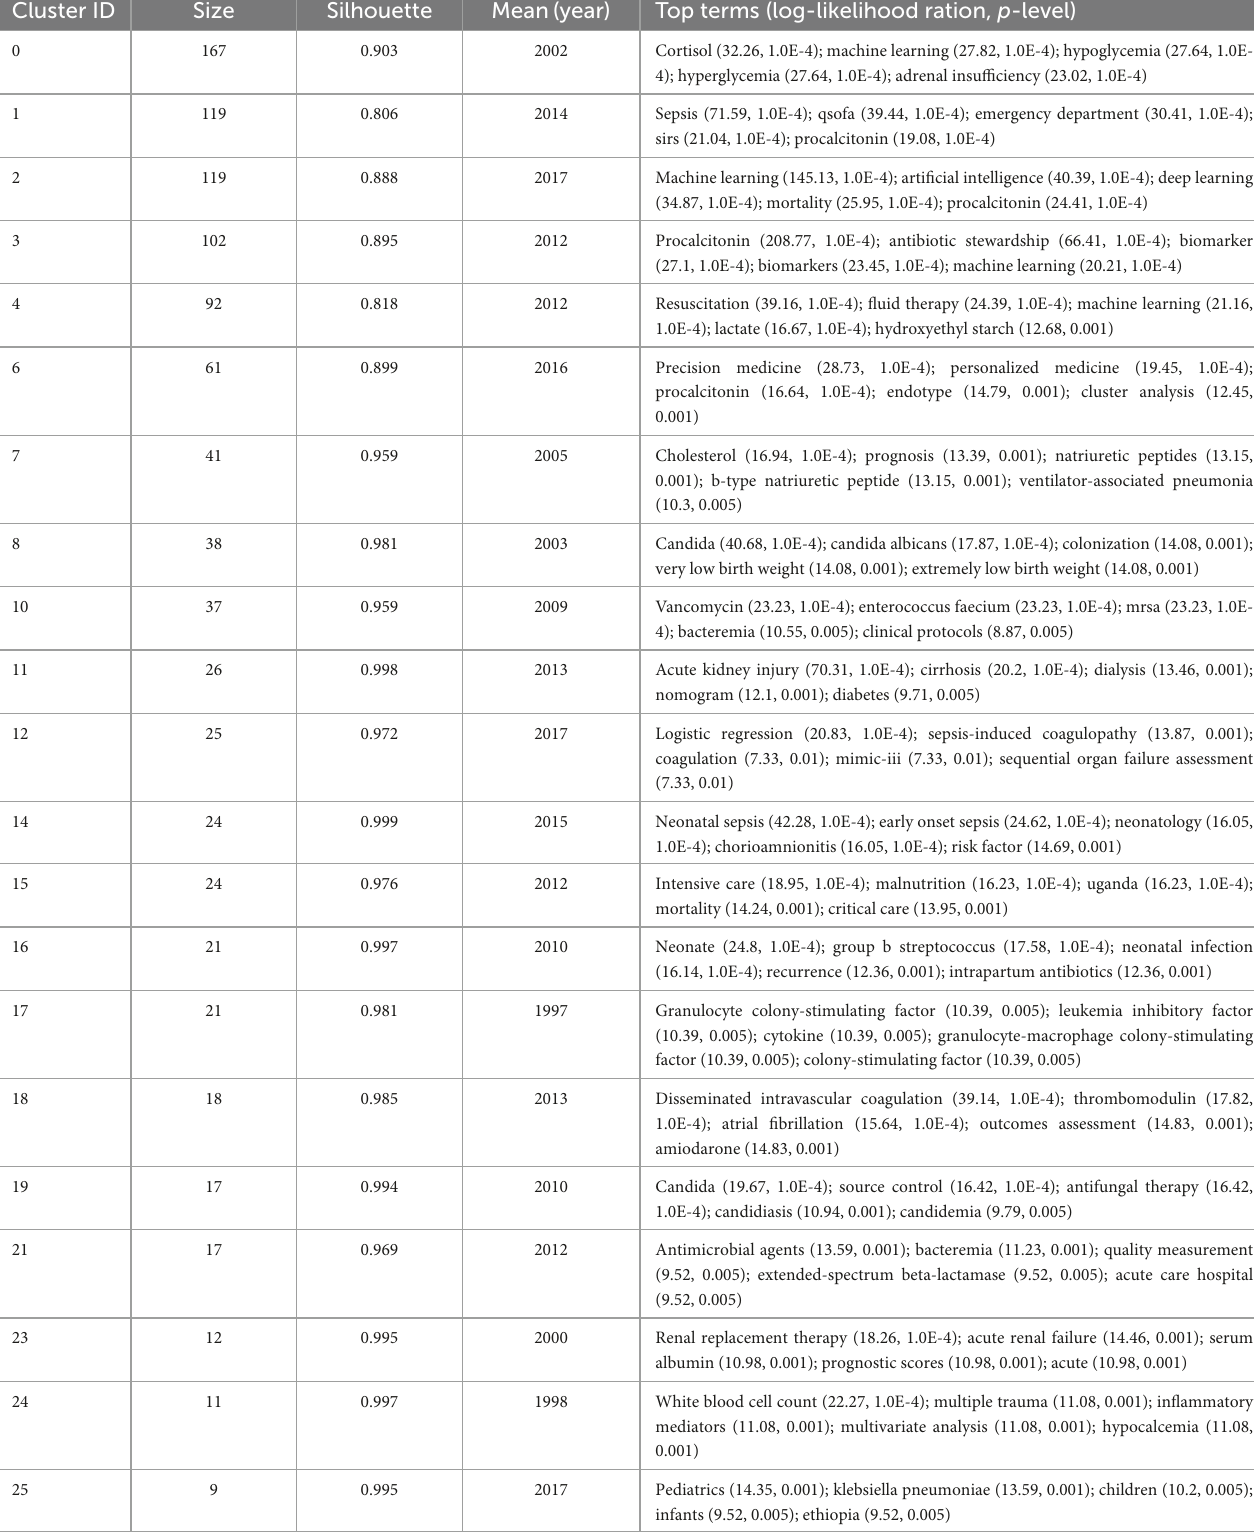
TABLE 5 Top 22 largest clusters of co-cited references on the application of artificial intelligence in sepsis from 2000 to 2021. Cluster ID Size Silhouette Mean (year) Top terms (log-likelihood ration, p -level)